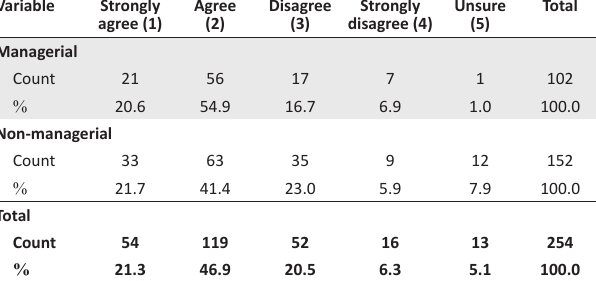
TABLE 8: Participants’ responses on the view that employees make recommendations on cost reduction.